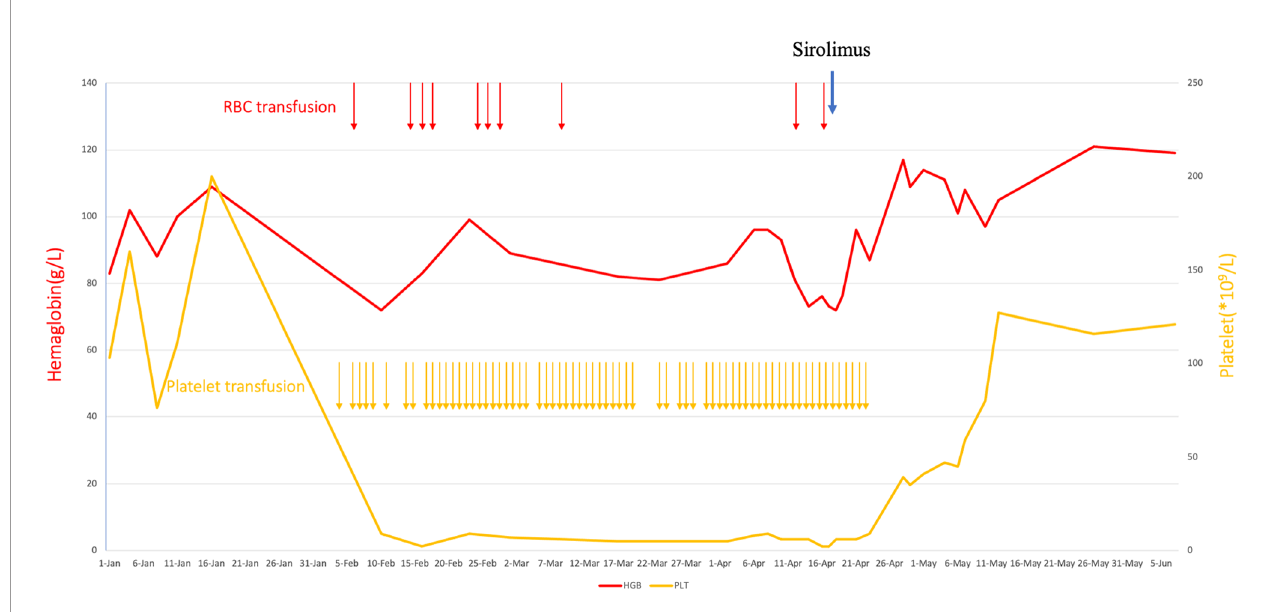
FIGURE 2 | Hematological adverse events and recovery after anti-CD19 CAR-T-cell therapy and sirolimus for r/r